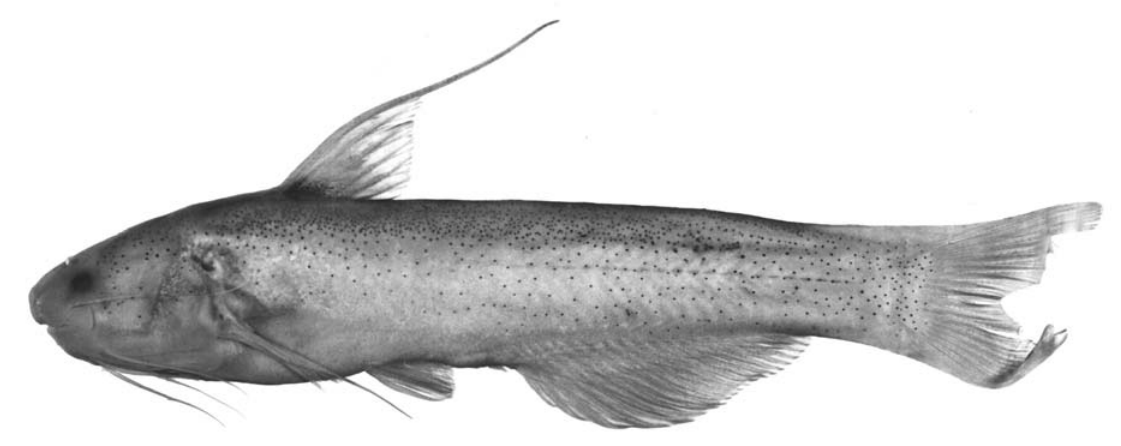
Fig. 9. Cetopsidium pemon , new species, mature male, AMNH 91375, 41 mm SL; Venezuela, Amazonas, río